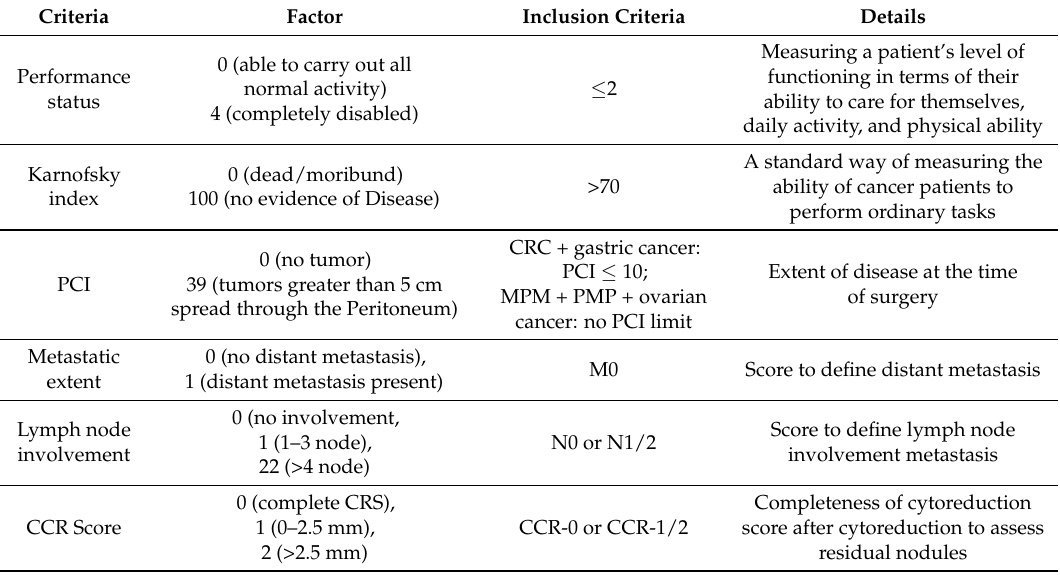
Table 5. Patient selection criteria used for